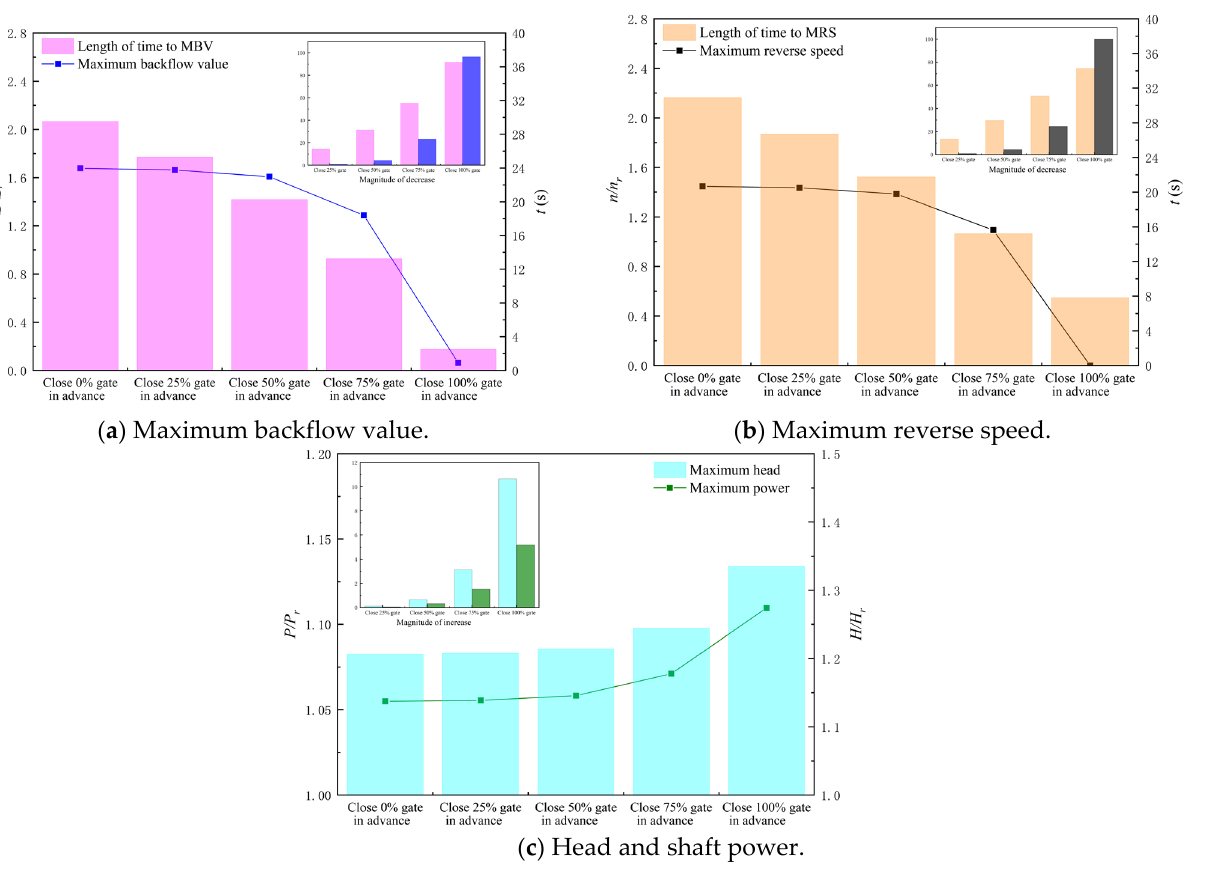
Figure 22. Statistics of the KCPs of the LAPS under different gate advance closing schemes (TTGC: 120 s).